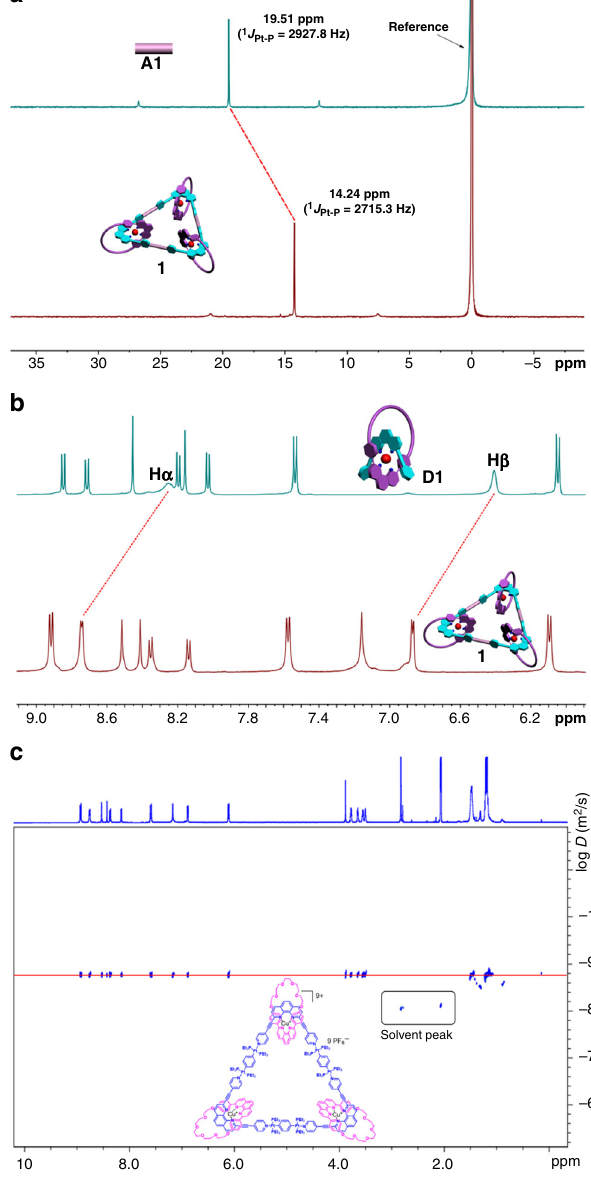
Fig. 3 NMR spectra of necklace 1 and related molecules. a Partial 31 P NMR spectra of 1 and A1 (202 MHz, acetone- d 6 , 298 K). b Partial 1 H NMR spectra of 1 and D1 (500 MHz, acetone- d 6 , 298 K). c 2-D DOSY spectrum of 1 (500 MHz, acetone- d 6 , 298